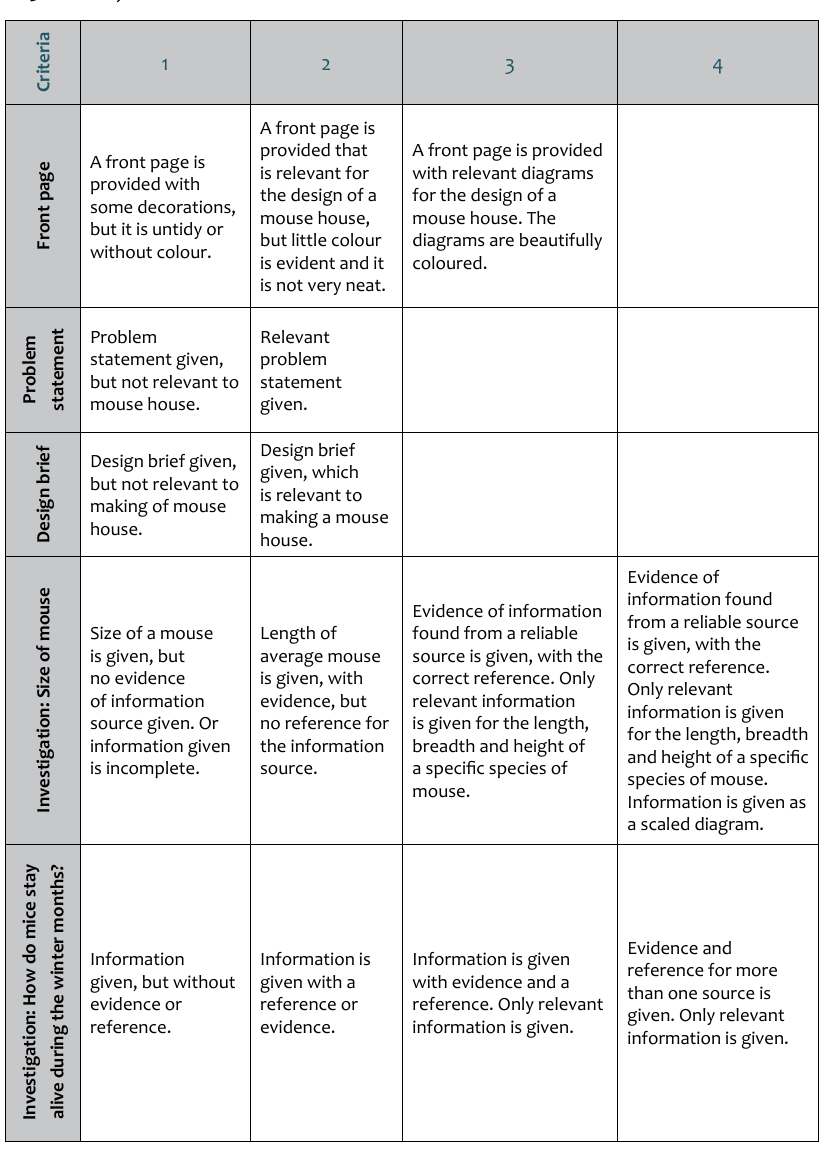
Table 1: Rubric for the assessment of the group work design of the mouse house (Total of 38 marks)